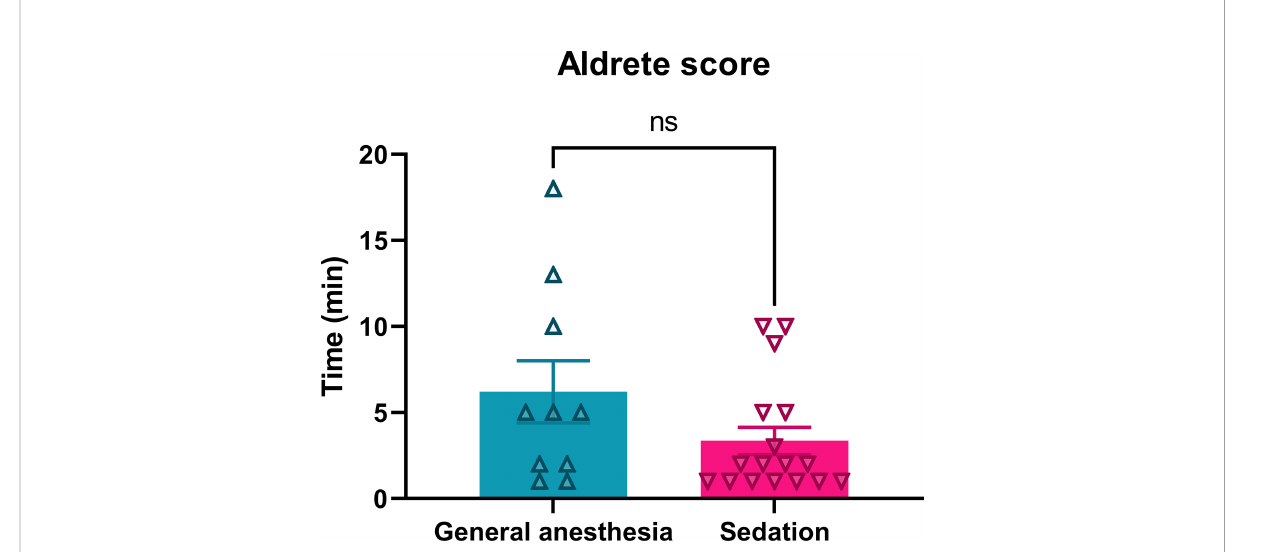
FIGURE 4 Recovery of patients treated with ECT performed under general or sedation procedures. Ns, nonsigni fi cant, p =